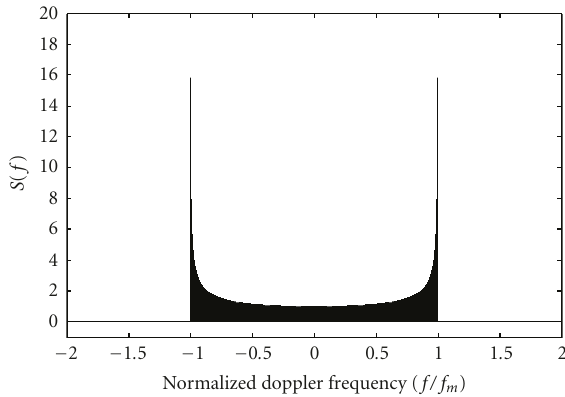
Figure 5: Doppler power spectrum according to normalized doppler